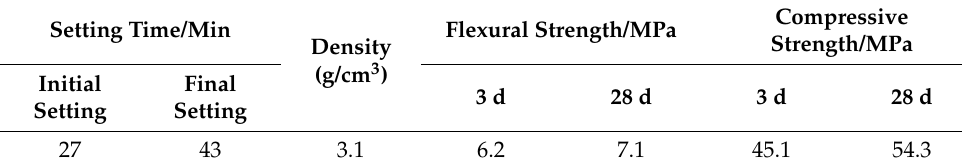
Table 1. Physical properties of SAC.